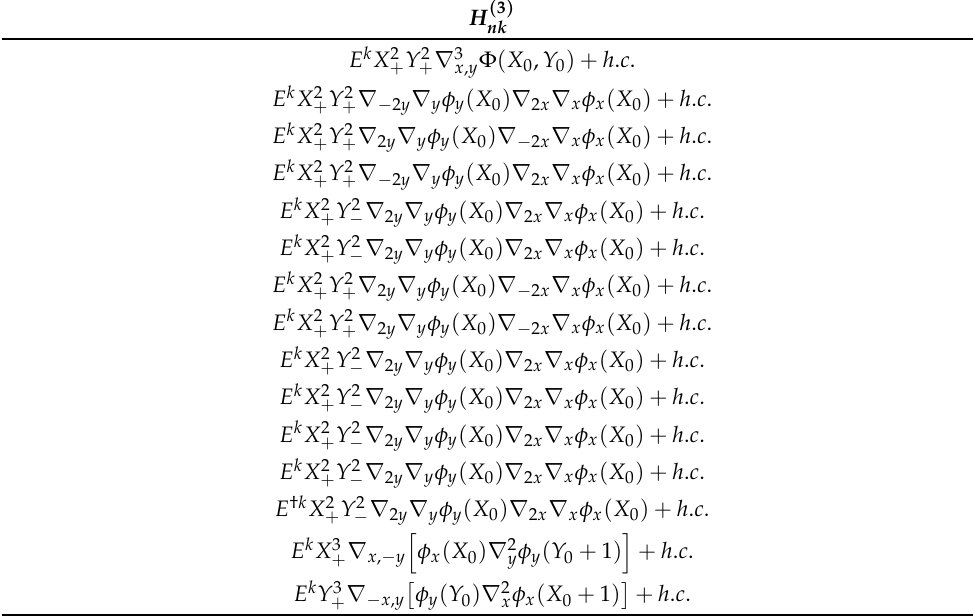
ε ( 3 ) for Hamiltonian ∼